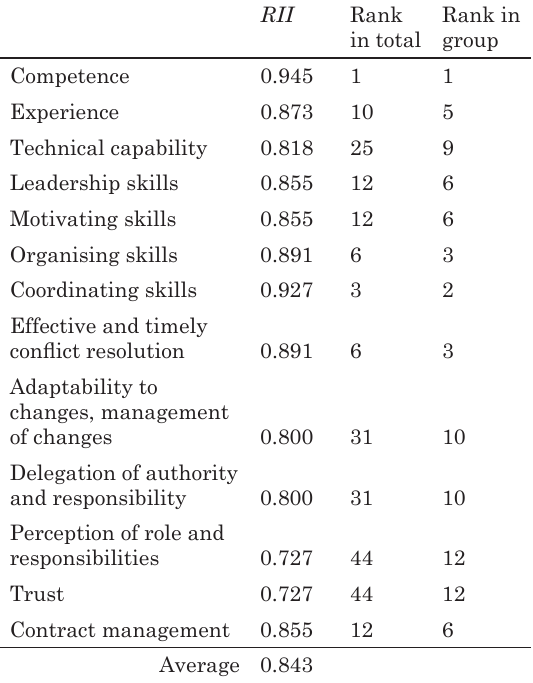
table 5. Summary of survey results on